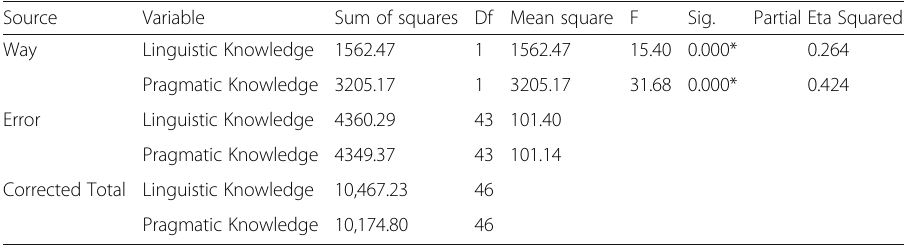
Table 3 Means and Standard Deviations of the Students ’ Pre- and Post- GST and DCT Source Variable Sum of squares Df Mean square F Sig.